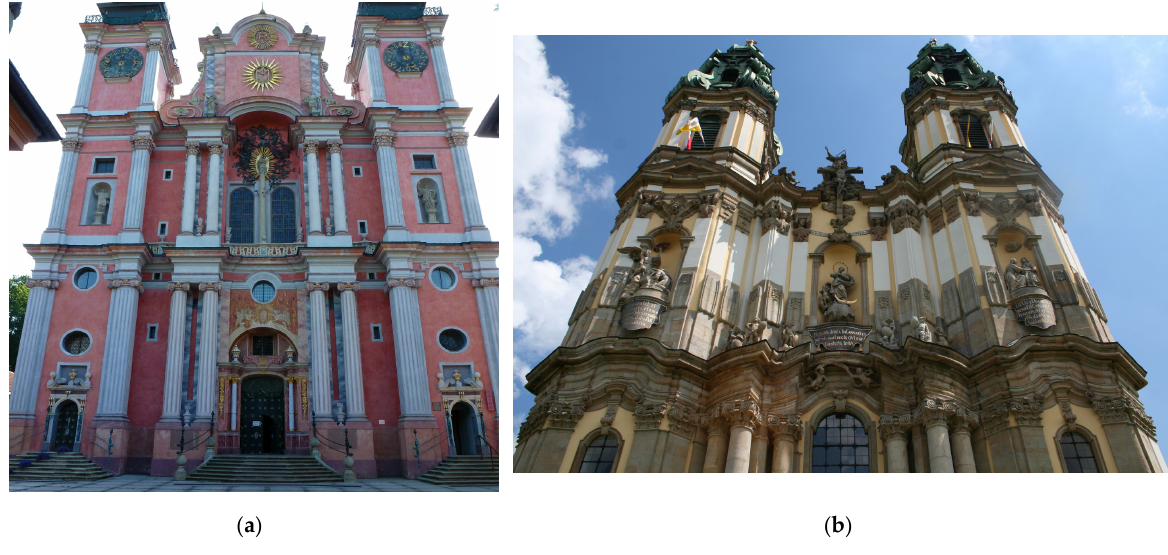
Figure 15. Continuity of multiplied elements of vertical division emphasized by color: ( a ) the façade of the church in Ś wi ę ta Lipka (1687–1695); ( b ) the façade of the monastery church in Krzeszów in Lower Silesia (1728–1733). Photos by